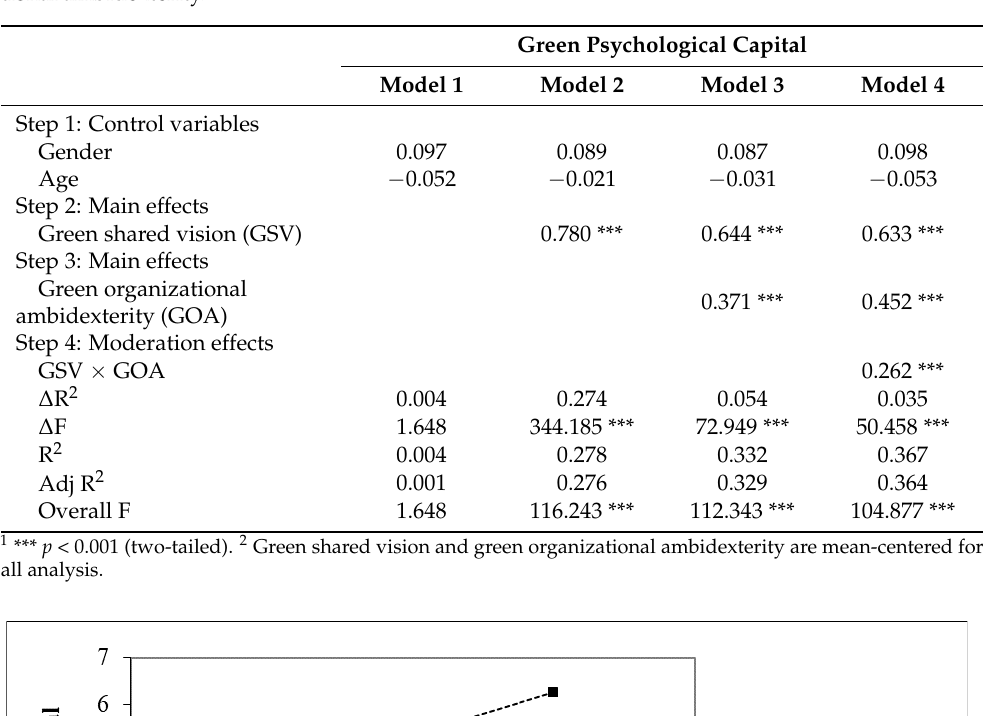
Table 6. Hierarchical regression results on green psychological capital moderated by environmental Table 5. Hierarchical regression results on green psychological capital moderated by green organiza- attitude. tional ambidexterity.